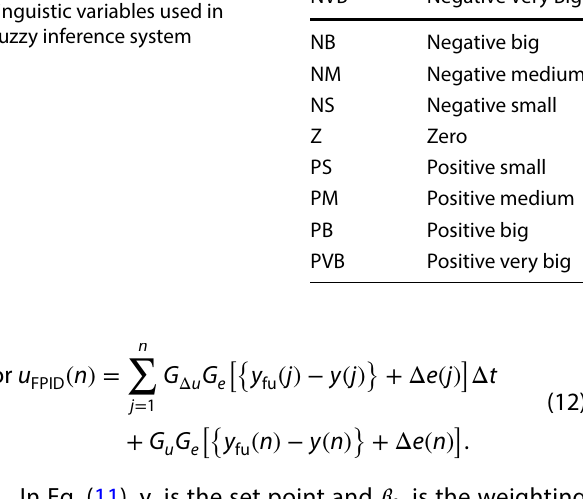
Fig. 4 Typical closed-loop response under set point change and subsequent load variation with change of error ( Δ e ) and weighting factor ( 𝛽 fu )